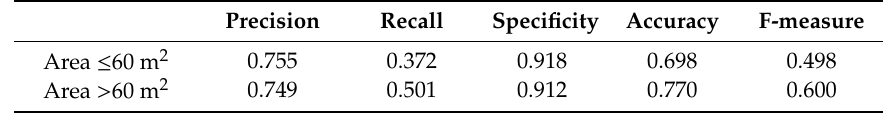
Table 13. Precision, recall, specificity, accuracy, and F-measure based on the confusion matrixes of Tables 11 and 12.